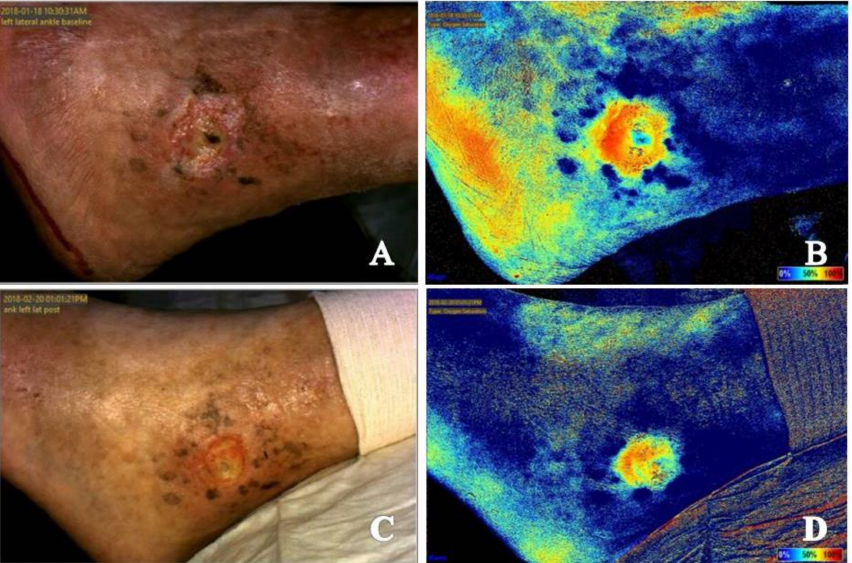
Figure 1. ( A ) Baseline clinical photograph; and ( B ) near-infrared image assessment of the left lateral ankle. Note on the near-infrared image the increased signal (color closer to 100% on rainbow scale on near-infrared image) in the periwound area and reduced signal with the wound bed, indicative of a chronic wound stalled in the inflammatory phase of wound healing. The mottled signal pattern seen about the wound is indicative of the presence of local ischemia. Increased signal noted in the lateral aspect of the foot in the location of the fifth metatarsal signals potential underlying infection. The patient had confirmed diagnosis of osteomyelitis of the fifth metatarsal. ( C ) Clinical photograph; and ( D ) near-infrared image assessment following vascular intervention. Note the reduction of signal within the periwound area and increased signal within the wound bed in the near-infrared image following revascularization. The reversal of signal from the baseline image is a positive prognostic indicator that the wound has transitioned to the proliferative phase of healing. Reduction in signal intensity in the area of the fifth metatarsal is evidence of positive response to treatment of underlying osseous